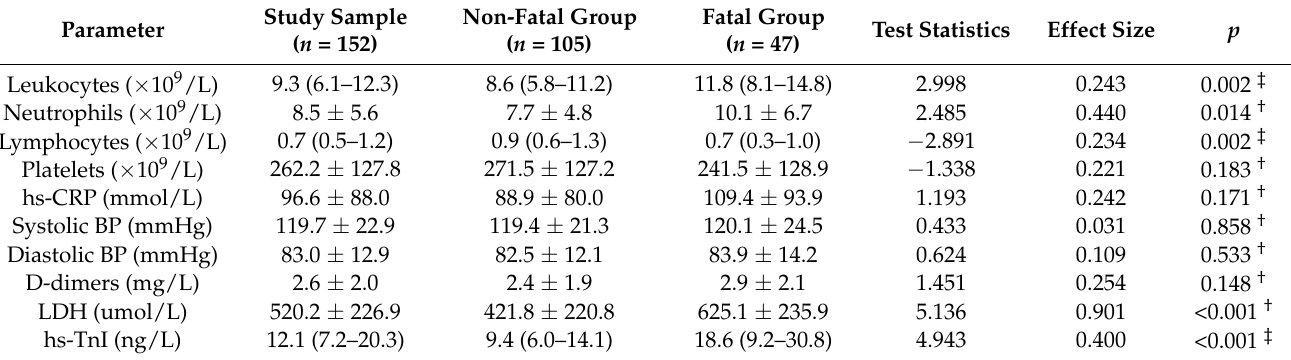
Table 2. Comparison of clinical and laboratory parameters between the fatal and the non-fatal group.